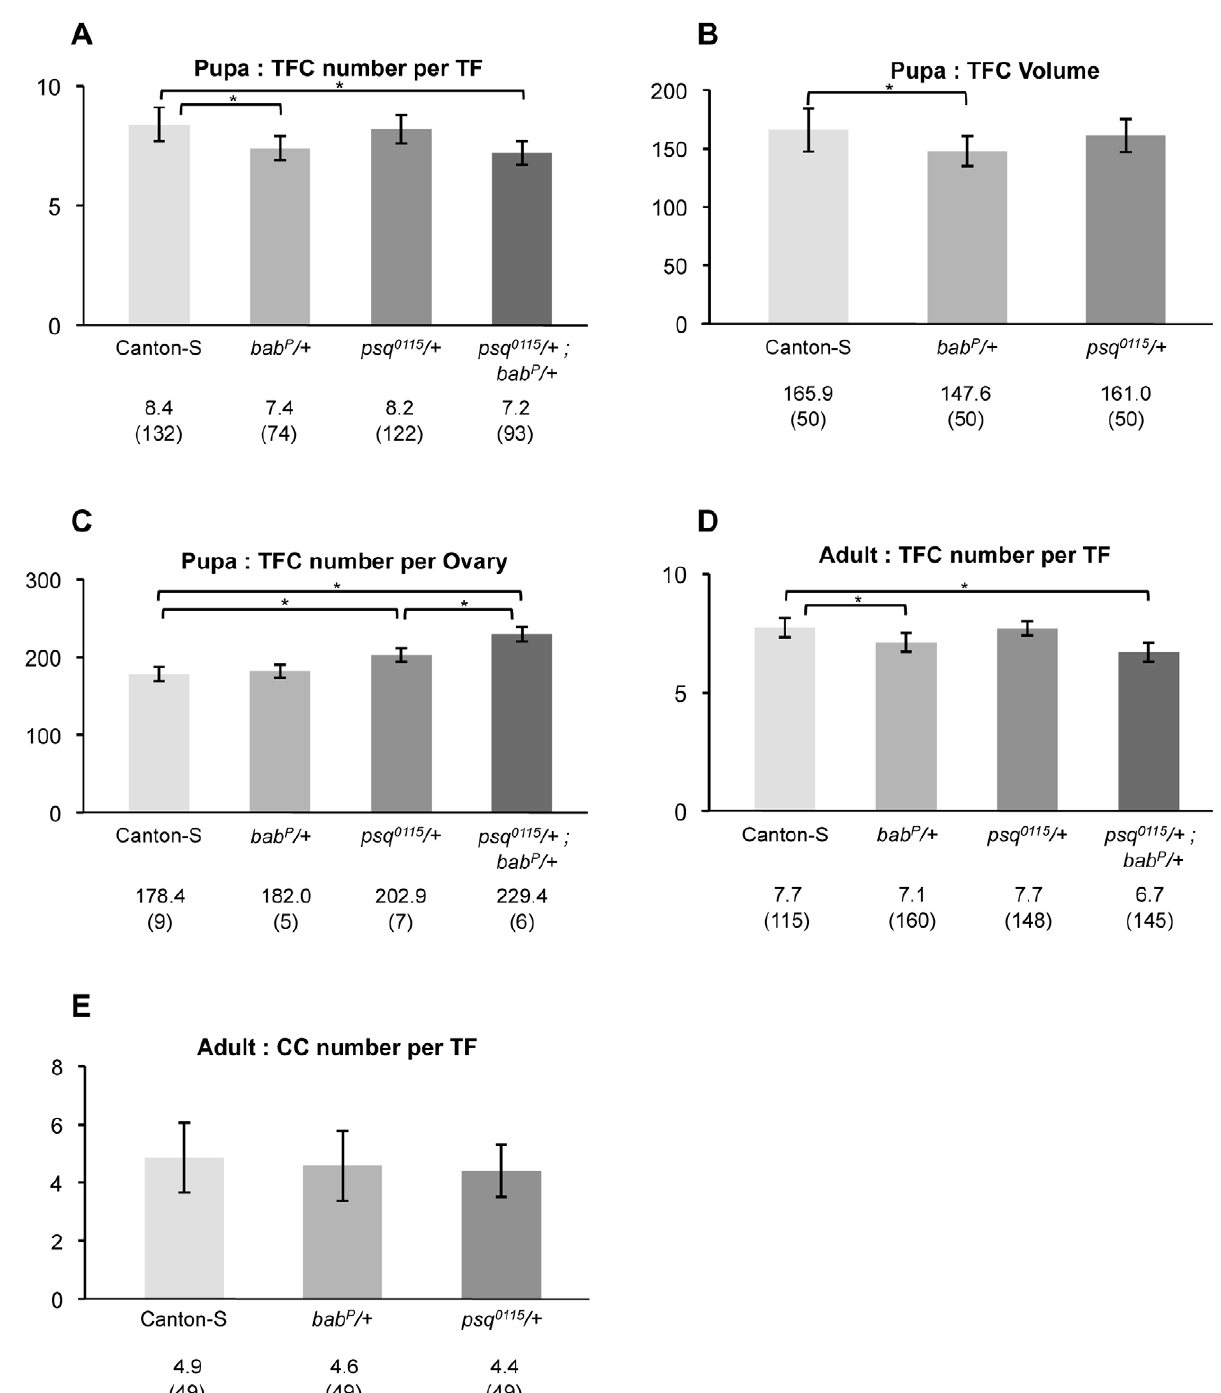
Figure 5. Quantitative analysis of cell number and size in psq and bab heterozygotes. (A) TFC number per TF at the early pupal stage. (B) TFC volume at the early pupal stage. (C) TFC number per ovary at the early pupal stage. (D) TFC number per TF in adults. (E) CC number per germarium in adults. Canton-S flies were used as a wild-type reference. Genotypes are given below each chart. In heterozygotes, + indicates wild type chromosomes from the Canton-S stock. For each genotype, values are expressed as the mean number (A, C–E), or mean volume (B) and sample size is given in parenthesis. Significant differences between genotypes are marked by a bracket and asterisk. All p values are given in Table S4.